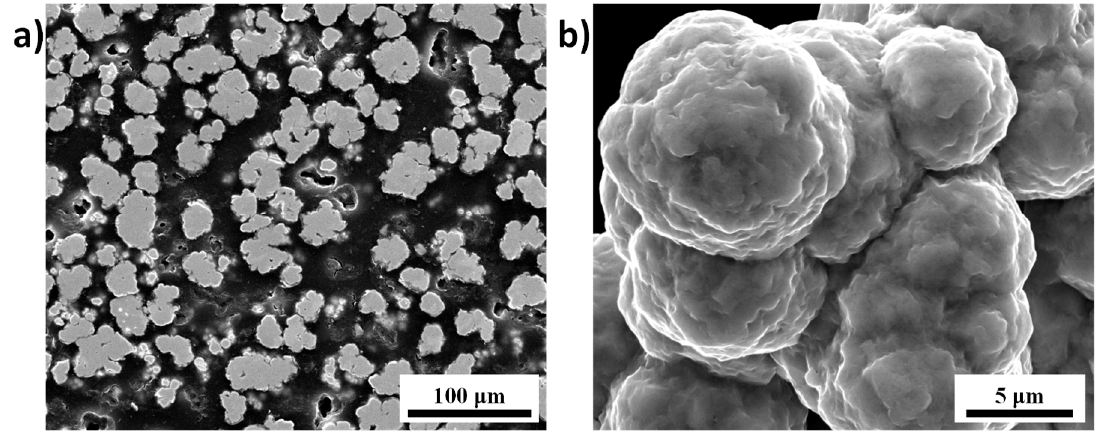
Figure 1. SEM images of as received nickel powder with ( a ) polished and ( b ) grains surfaces.